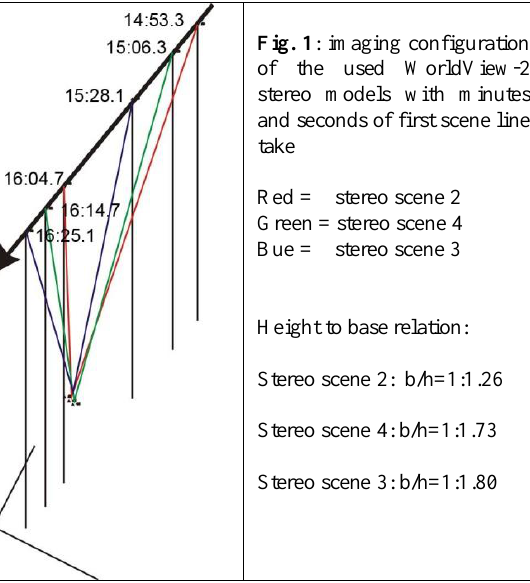
Fig. 1 : imaging configuration